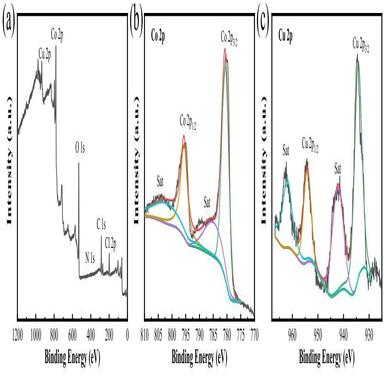
XPS spectra of Cu-IM/Co-MOF 250: (a) survey, (b) Co 2p, and (c) Cu 2p.